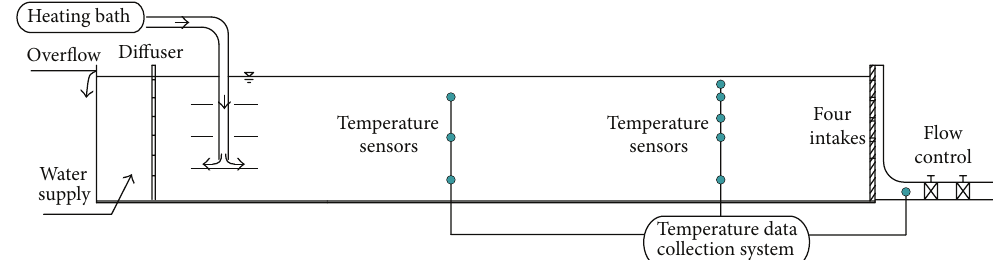
Figure 1: Schematics of selective withdrawal using a side-type orifice intake.